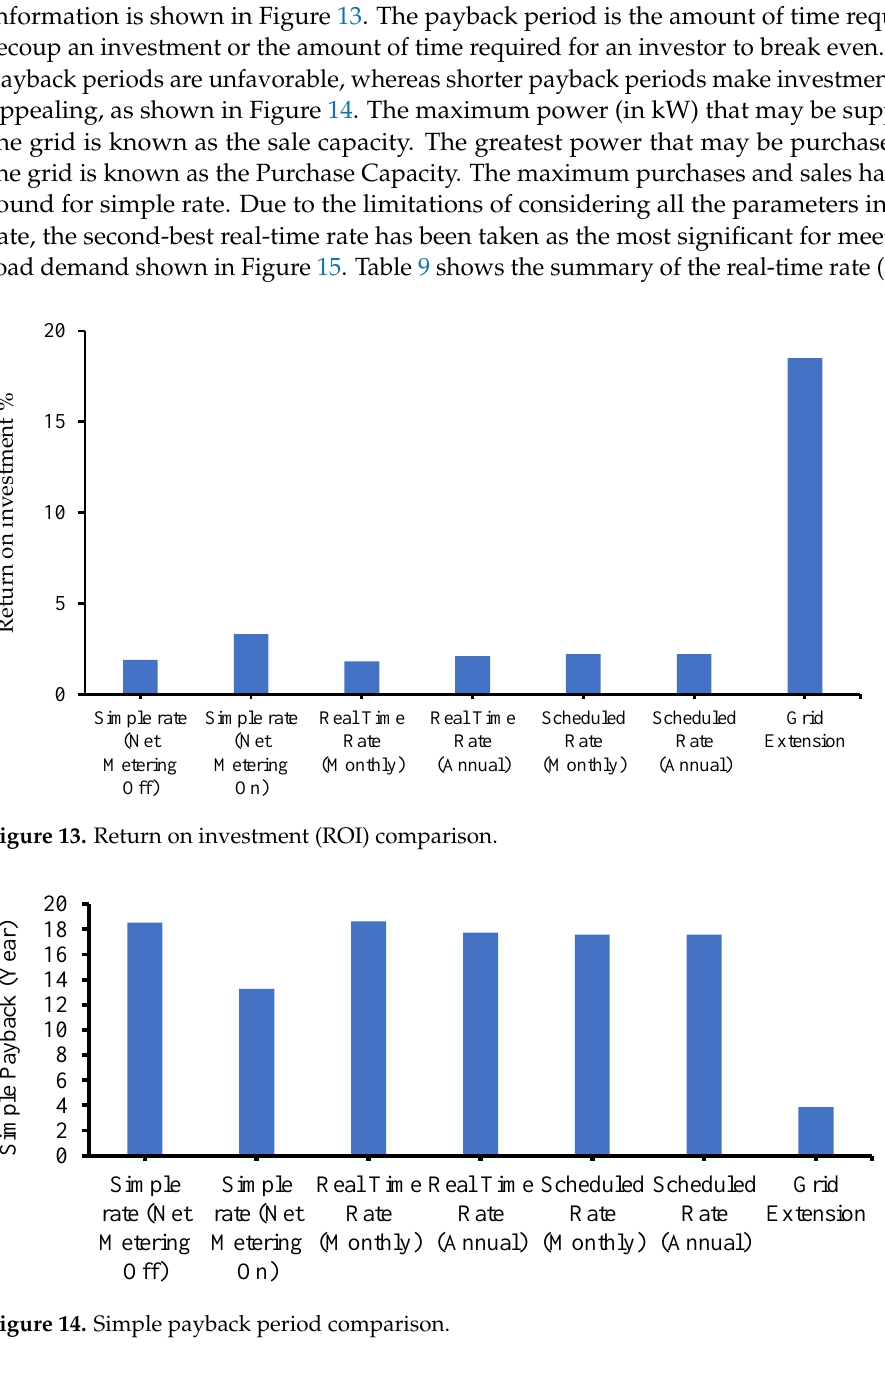
Figure 14. Simple payback period comparison.